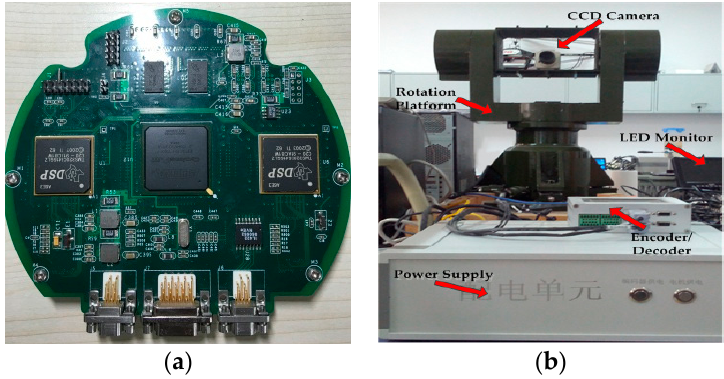
Figure 11. Real-Time tracking system: ( a ) embedded system; and ( b ) servo system.